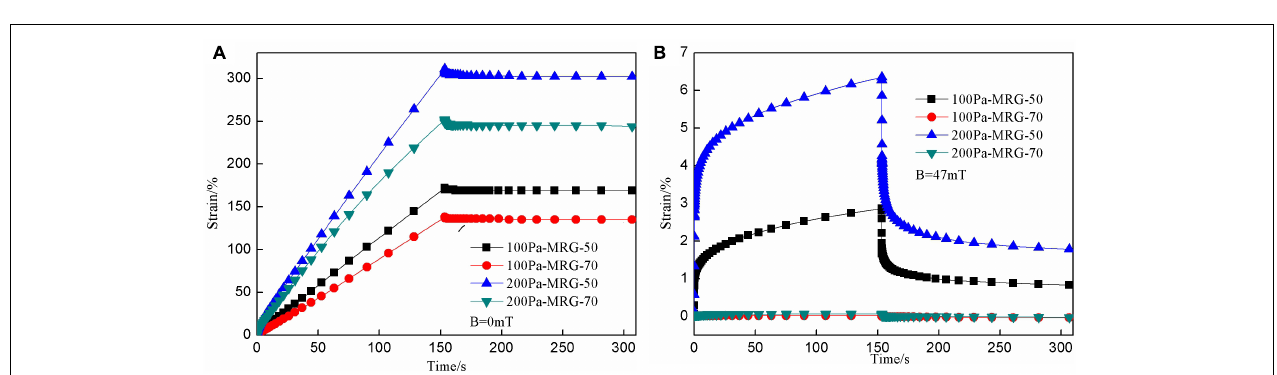
FIGURE 7 | Creep and recovery curves of MRG under the combined action of 50 Pa stress and different magnetic fields.